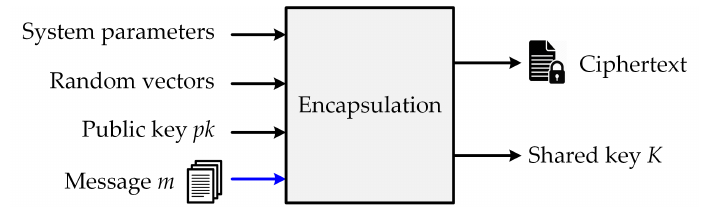
Figure 4. Encapsulation process of a key-establishment algorithm.